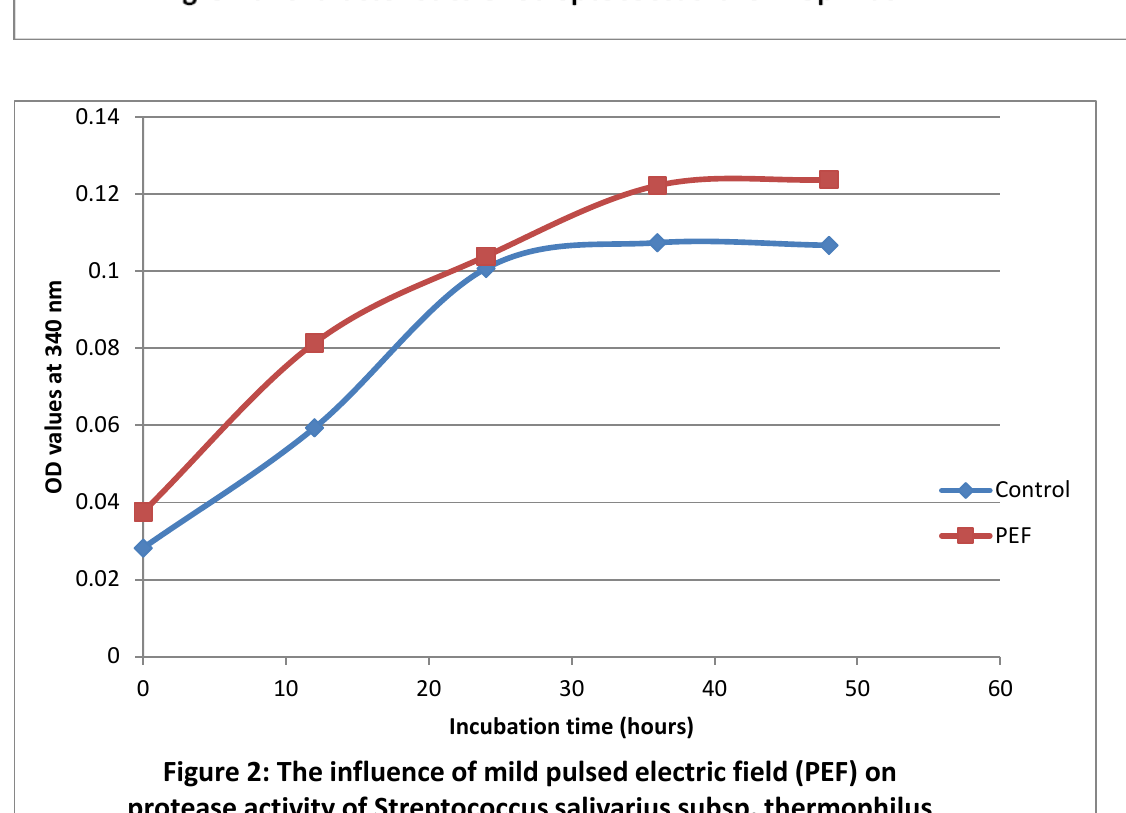
Figure 2: The influence of mild pulsed electric field (PEF) on protease activity of Streptococcus salivarius subsp.